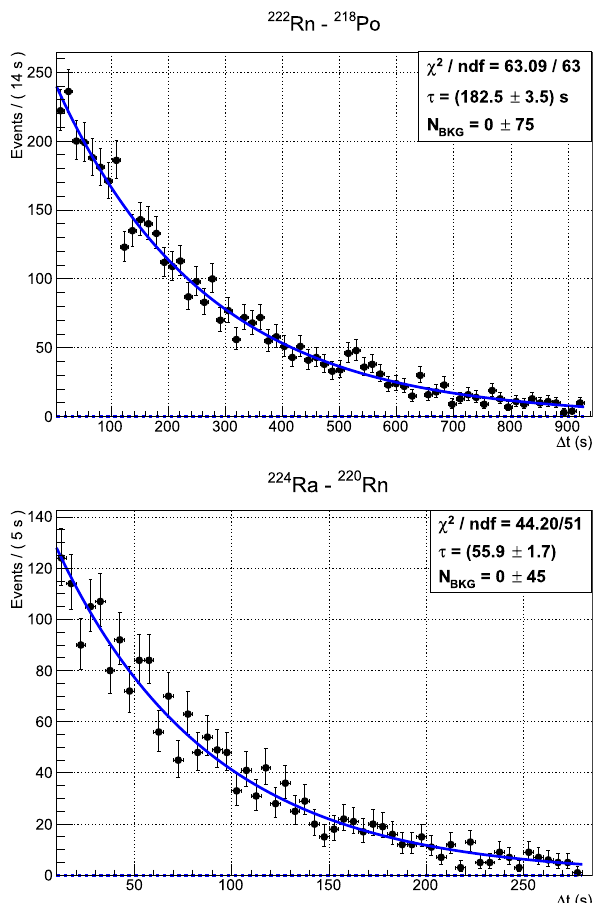
Fig. 3 Distribution of the Δ t between couples of parent–daughter events in the 238 U ( 222 Rn– 218 Po, left) and 232 Th ( 224 Ra– 220 Rn, right) decay chains. The fit function (solid line) is composed by an exponen- tial plus a flat background (dashed line at zero counts) to account for possible random delayed coincidences, whose integral (N BKG ) even- tually results to be compatible with zero in both cases. The half-life parameter reconstructed by the fit is compatible in both cases with the values reported in literature, thus confirming the effectiveness and the reliability in the identification of delayed coincidences